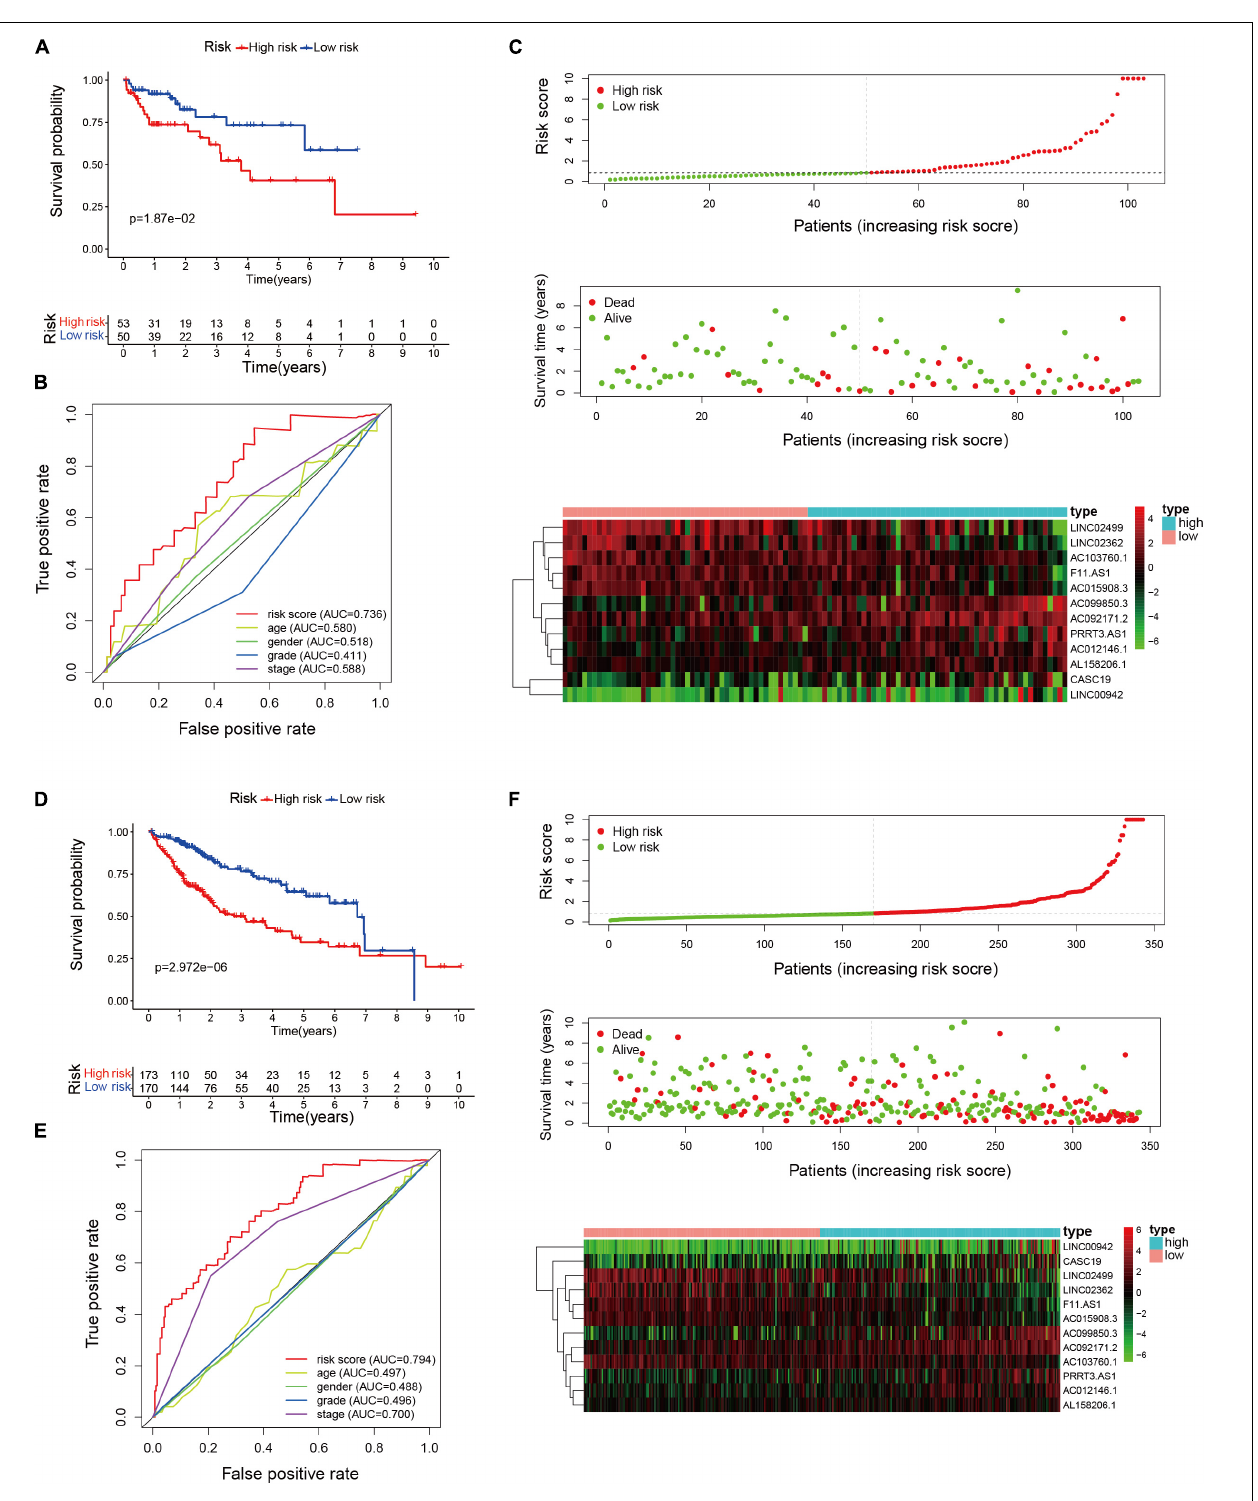
FIGURE 3 | Validation of the EMT-related lncRNAs risk signature in the testing and entire cohorts. (A) Kaplan–Meier survival analysis of the high- and low-risk groups in testing cohort. (B) The precision of the prognostic model was assessed with multi-indicator receiver operating characteristic (ROC) curves in testing cohort. (C) Risk score curves, survival status, and heatmap of lncRNAs in the testing group. (D) Kaplan–Meier survival analysis of the high- and low-risk groups in entire cohort. (E) Multi-indicator receiver operating characteristic (ROC) curves in entire cohort. (F) Risk score curves, survival status, and heatmap of lncRNAs in the entire